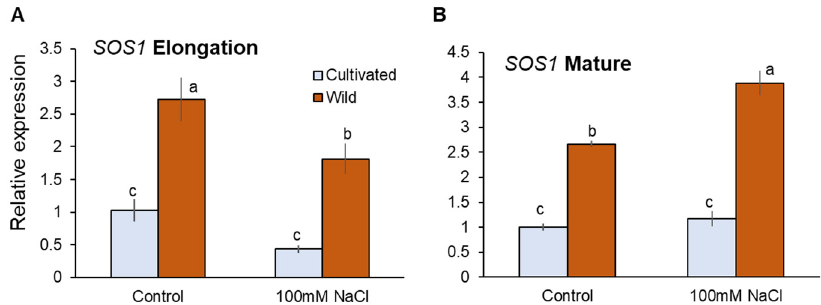
Figure 9. RT-qPCR analysis of the gene expressions of SOS1 in mature ( A ) and elongation ( B ) root zones of cultivated and wild rice species under control and salinity (100 mM NaCl, 48 h) conditions. Different letters indicate significant differences ( p < 0.05, one-way ANOVA followed by LSD tests). Mean ± SE ( n = 3).